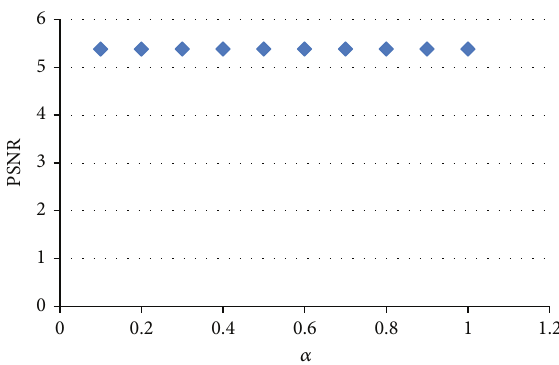
Figure 4: Choice of integer 𝛼 at 𝛾 = 1 , for “Boat” corrupted by Gaussian noise with 𝜎 = 25 .